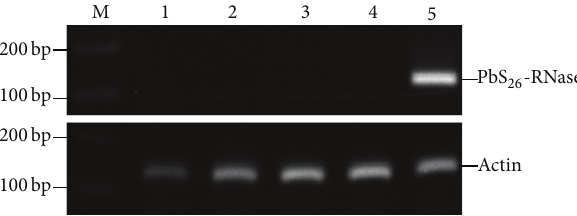
Figure 4: Semi-qPCR for the PbS tion in different tissues/organs. 1–5: roots, stems, leaves, stamens, and